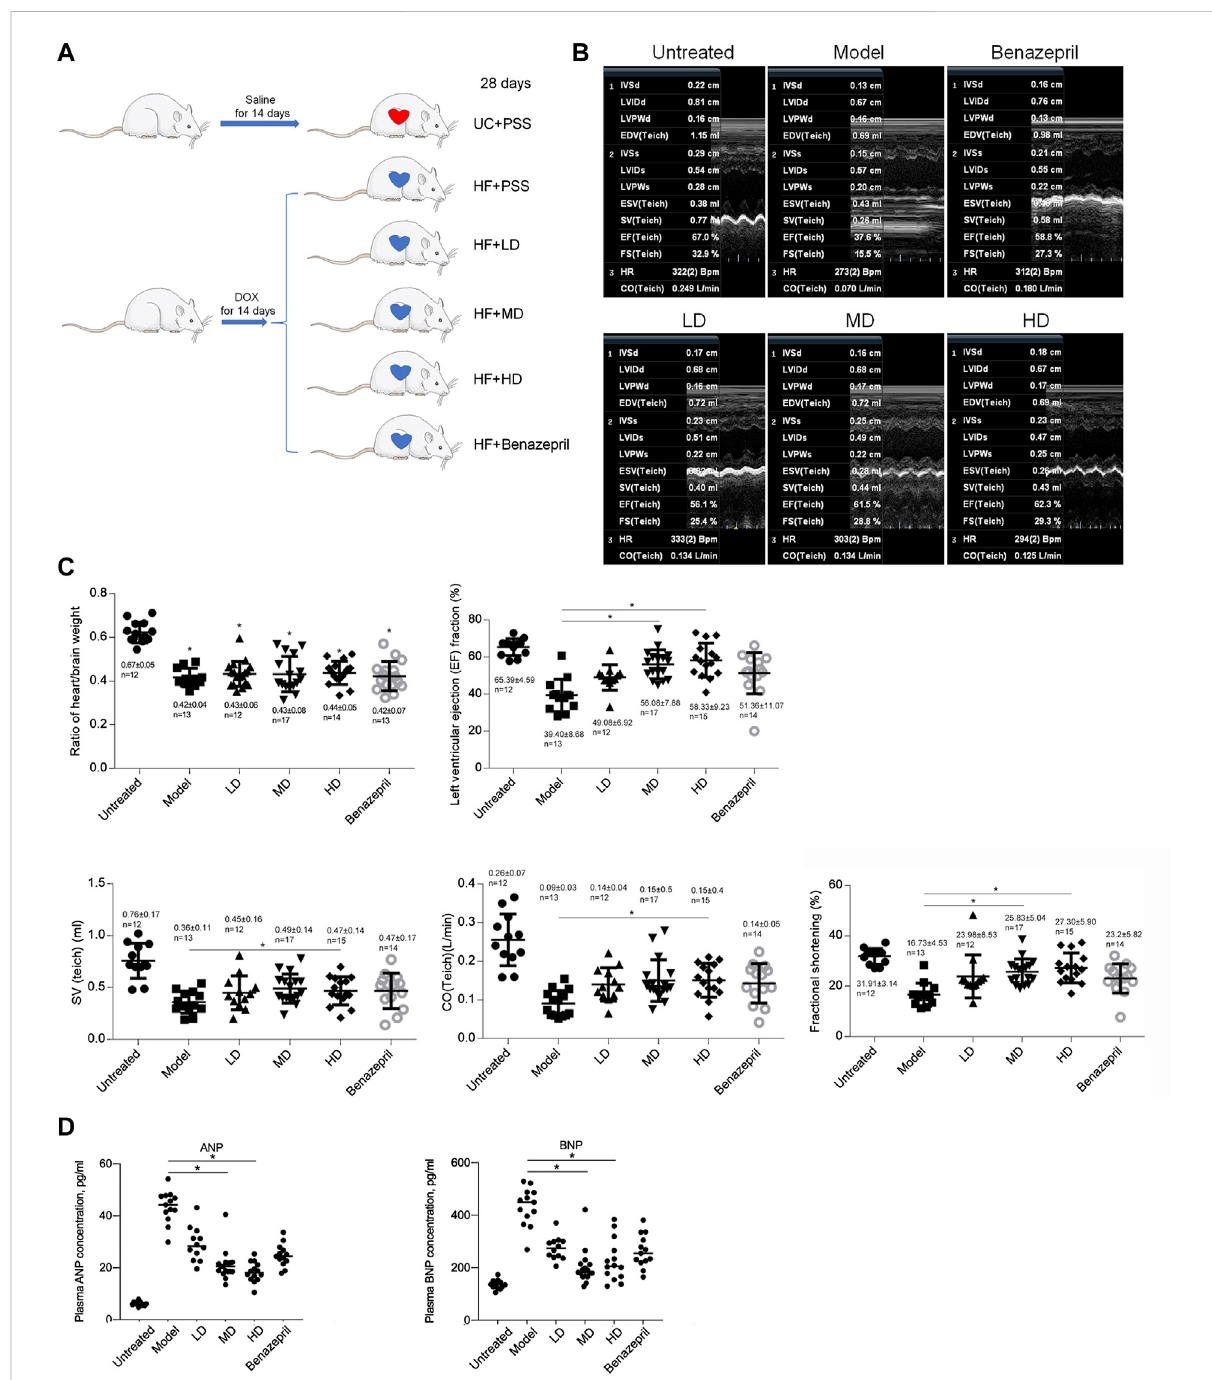
FIGURE 2 Model building and transthoracic echocardiography to evaluate the cardiac function of rats. (A) building of heart failure of a rat model. UC + PBS: untreated group fed with thesame volume of PBS; HF + PBS: heart failure group fed with the same volume of PBS; HF + LD: heart failure group fed with a low dose of YXX keli; HF + MD: heart failure group fed with a middle dose of YXX keli; HF + HD: heart failure group fed with a high dose of YXXkeli;HF+Benazepril:heartfailuregroupfedwithBenazepril. (B) .Transthoracicechocardiographywasperformedafterallexperiments. (C) . In different groups, cardiac function was performed. * p < 0.05, vs. Model group. (D) . ANP and BNP in different groups were measured. * p < 0.05, vs. Model